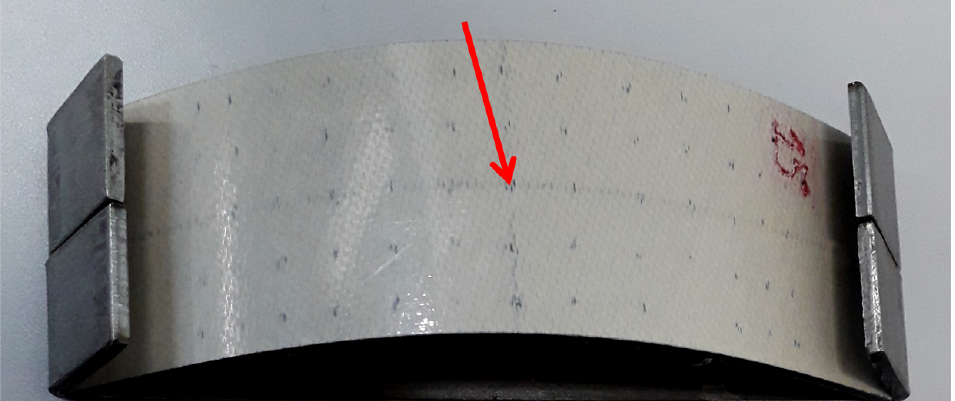
Figure 1. Schematic of the transverse impact